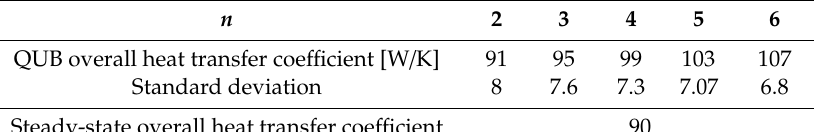
Table 1. QUB experiment during winter months at di ff erent levels of power.